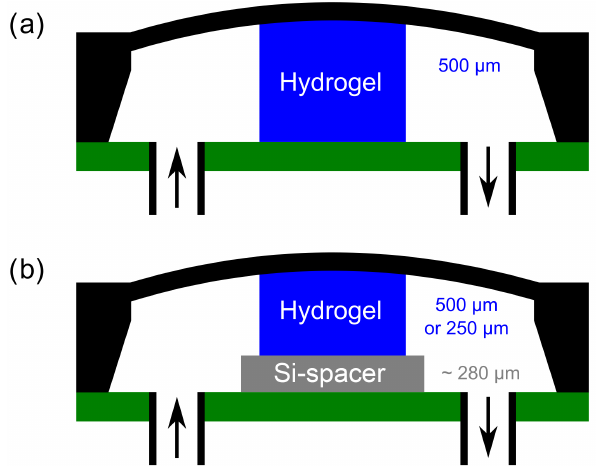
Figure 2. Sensor setups: (a) 500µm thick hydrogel body after syn- thesis without silicon spacer, (b) 250 or 500µm thick hydrogel body after synthesis with silicon spacer (thickness ca.